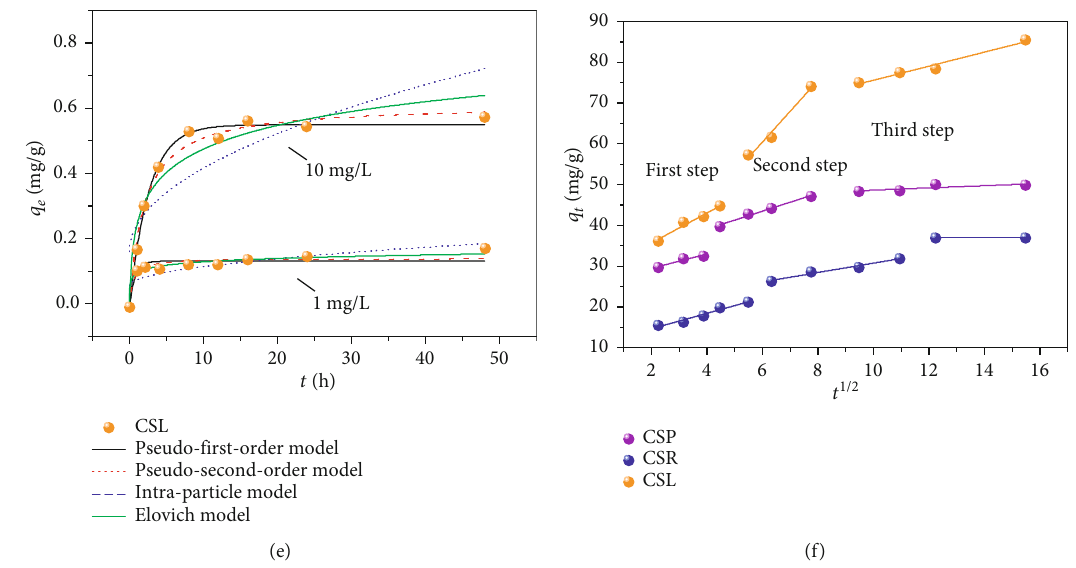
Figure 8: Adsorption kinetics of corn stover pith, rind, and leaf towards sulfadiazine (a, c, e) and methylene blue (b, d, f). Table 4: Kinetic parameters for di ff erent parts of corn stover in adsorption of sulfadiazine with two solution concentrations. C -1 0 (mg L